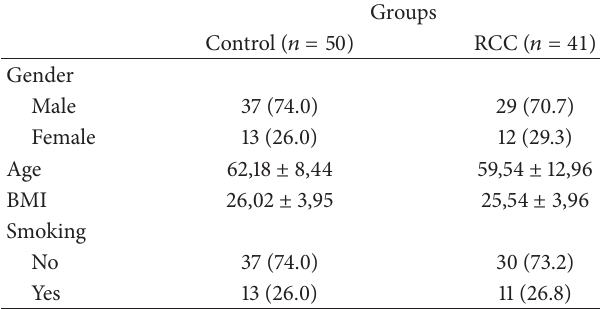
Table 1: Demographic data of the groups.